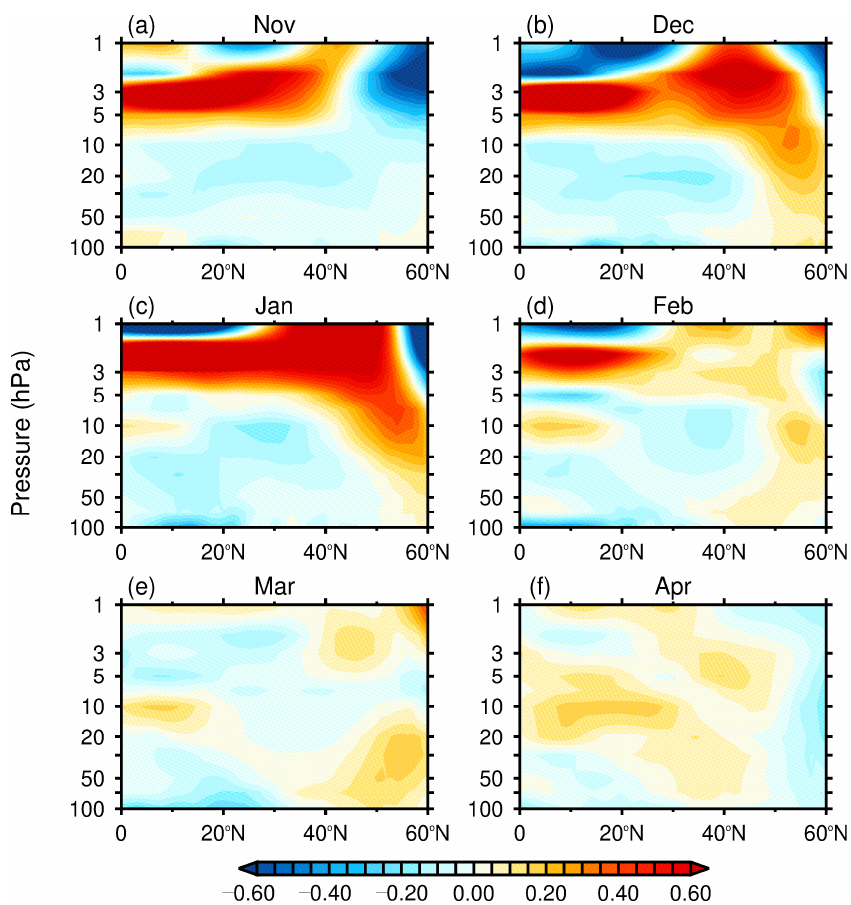
Figure 7. Month ‐ to ‐ month evolution of the meridional wind anomalies ( a – f ) from November 2010 to April 2011. Anomalies are defined as the deviations of meridional wind from its seasonal cycle. Figure 8 further shows the month ‐ to ‐ month evolution of the zonal ‐ mean wind anom ‐ alies from November 2010 to April 2011, in order to confirm the effect of a SPV on the weakened shallow branch of the residual circulation. Positive zonal ‐ mean wind anoma ‐ lies from January 2010 to March 2011 imply an anomalous SPV (Figure 8c–e), correspond ‐ ing to the weakened residual circulation (Figure 4c–e). In April 2011, the negative zonal ‐ mean wind anomalies in the high latitudes imply the collapse of the polar vortex (Figure 8f), and the corresponding weakened residual circulation disappeared (Figure 4f).